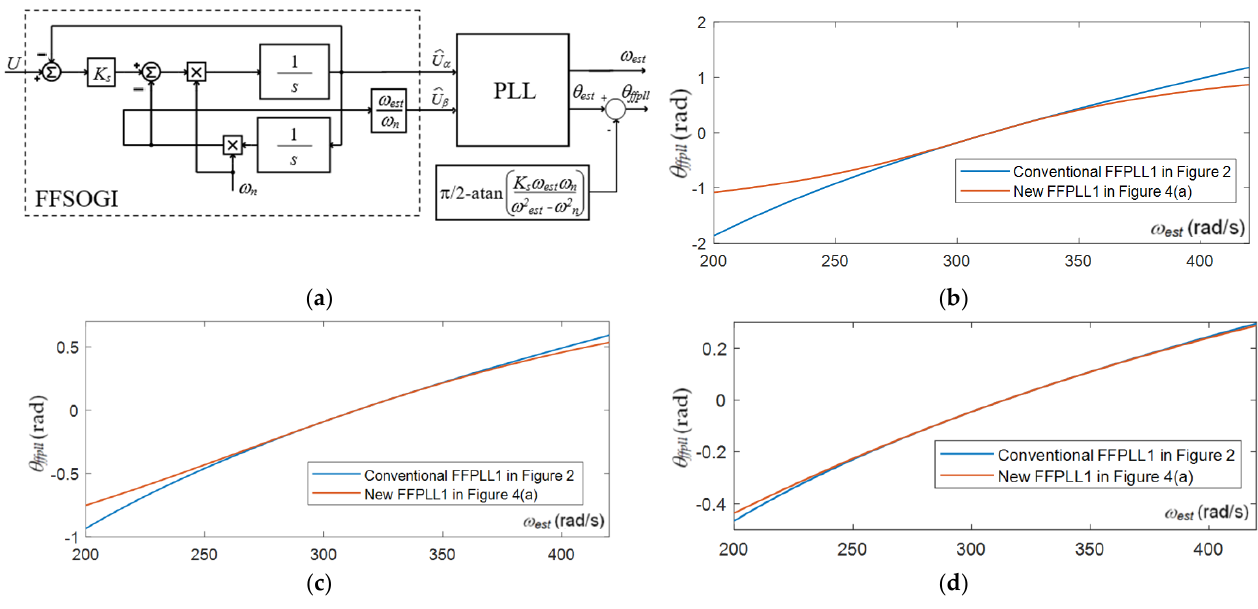
Figure 4. The ( a ) FFPLL1 structure with improved estimated phase angle correction, ( b ) compari- son between the conventional (5) and new (7) FFPPL phase compensation, calculated for ω est = 314 rad/s and ( b ) K s = 0.5, ( c ) K s = 1, ( d ) and K s = 2. and ( b ) K s = 0.5, ( c ) K s = 1, ( d ) and K s =